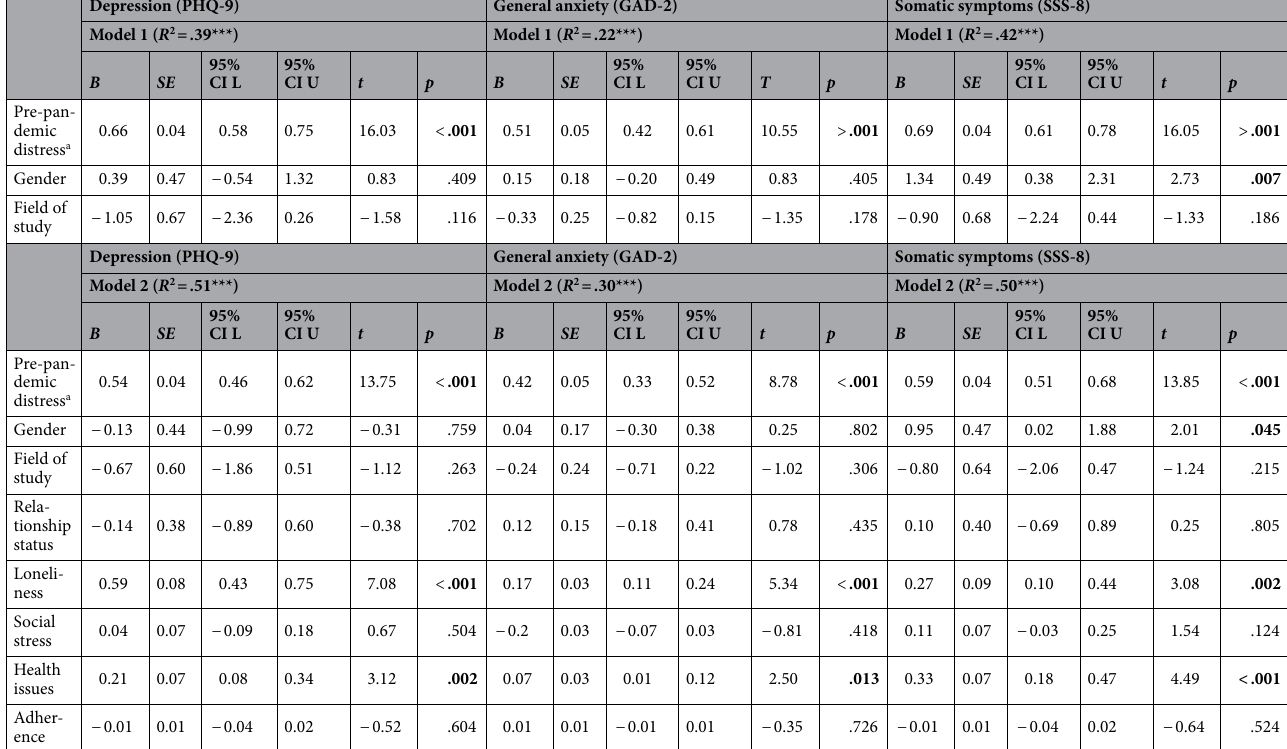
Table 4. Linear regressions of associations between depression, anxiety, and somatic symptoms with gender, field of study, relationship status (model 1), and loneliness, social stress due to the pandemic, health issues due to the pandemic, and adherence to pandemic containment measures (model 2). Bold values are statistically significant. CI Confidence interval, PHQ-9 Patient health questionnaire-9, GAD-2 Generalized anxiety disorder-2, SSS-8 Somatic symptoms scale-8. a In the corresponding outcome variable (PHQ-9, GAD-2, SSS-8, respectively).